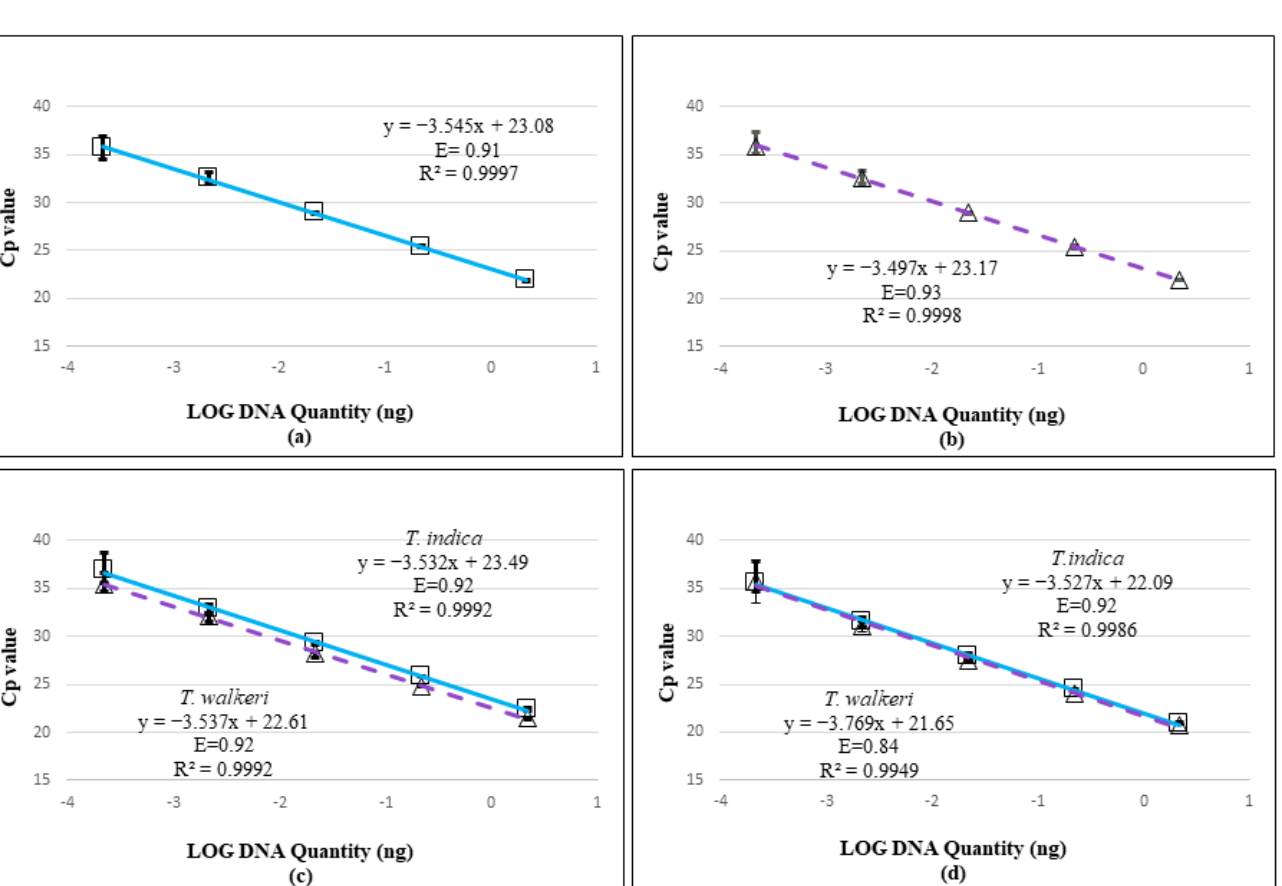
Figure 1. Standard curves showing the regression between DNA log quantities (ng, x-axis) and cycle thresholds (Cp, y-axis) for the four qPCR assays, generated with serial dilutions (~2.2 to ~2.2 × 10 − 4 ng/ µ L) of the target species, T. indica DAOMC 236416 (squares/solid line) and T. walkeri DAOMC 236422 (triangles/dotted line). ( a ) TinOG09272 specific to T. indica ; ( b ) TwaOG10415 specific to T. walkeri ; and complex-specific detecting both species, ( c ) OG08220 and ( d ) OG01193. Plotted are the average Cp values for the initial 3 replicates run for each dilution and error bars for all replicates (3 for the first three dilutions, 18 for the last 2).